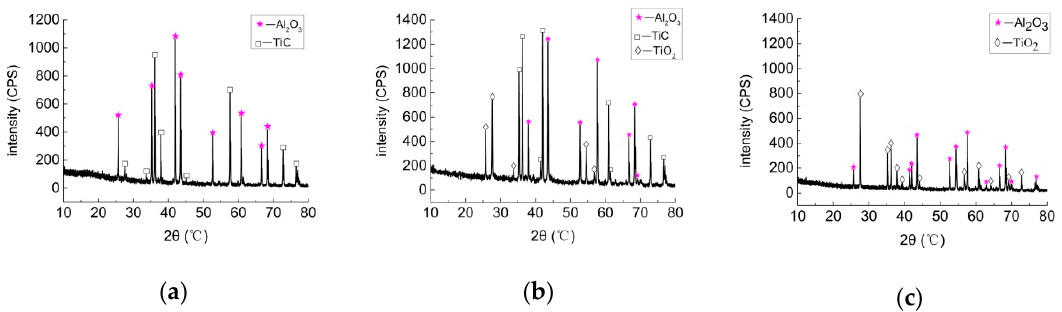
Figure 4. XRD patterns of the ceramic tool oxidation products at different temperatures. ( a ) 973 K, Al 2 O 3 : PDF#70-3319; TiC: PDF#65-8803; ( b ) 1173 K, Al 2 O 3 : PDF#70-3319; TiC: PDF#65-8803; TiO 2 : PDF#21-1236; ( c ) 1273 K, Al 2 O 3 : PDF#16-0394; TiO 2 : PDF#21-1236;